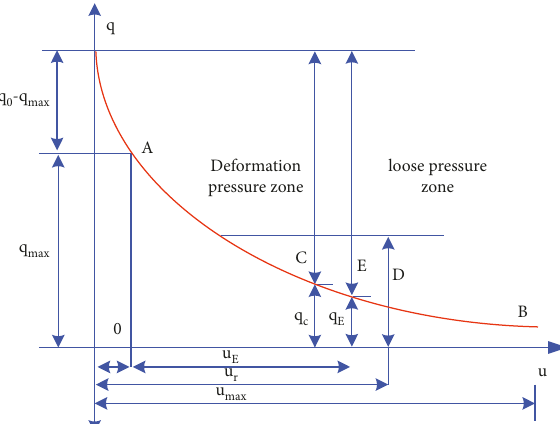
Figure 3: Schematic diagram of interaction principle.